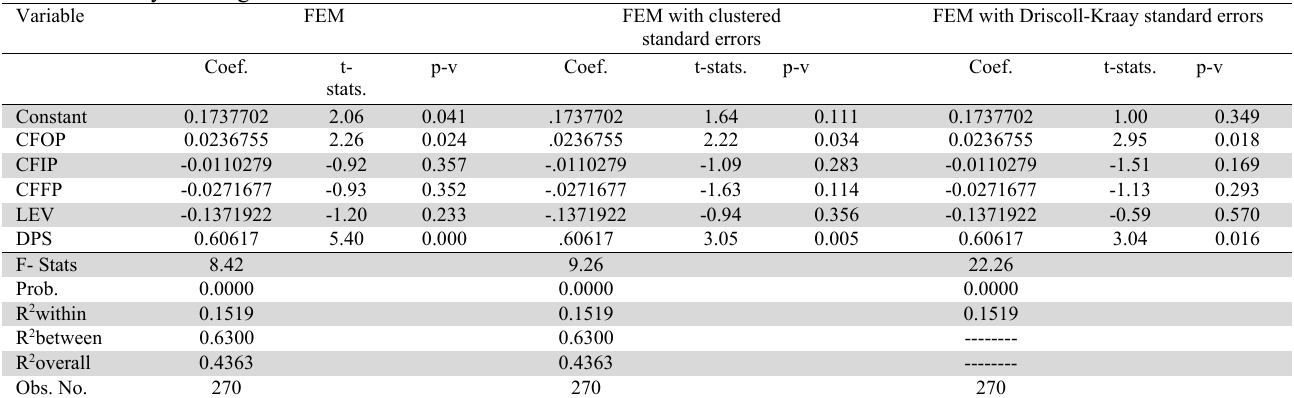
Results of analysis using standard errors estimates for